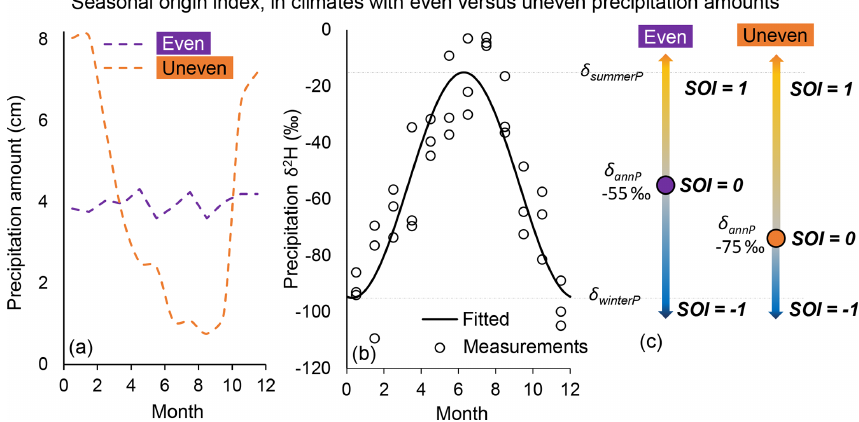
Figure 1. Calculation of the seasonal origin index (SOI). As a hypothetical example, consider one site that receives equal precipitation amounts throughout the year and another site that receives more precipitation in winter (a) , but both have the same seasonal isotopic cycle (b) . In this example, the volume-weighted average precipitation is − 75‰ δ 2 H in the uneven-precipitation site and − 55‰ δ 2 H in the even- precipitation site (c) ; these values mark SOI = 0. Thus, if water with − 60‰ δ 2 H was observed in xylem in the uneven-precipitation site, SOI would be positive, indicating that each millimeter of rain that fell during the summer made a larger contribution to xylem water than each millimeter of rain that fell during the winter (even though, owing to the greater precipitation in winter, winter precipitation made up more than 50% of the xylem water). Panel (b) also shows how the seasonal precipitation isotope cycle is defined by a fitted sinusoid, such that the amplitude captures typical summer and winter peaks and not the absolute bounds of possible values (i.e., SOI of soil or xylem water can be higher than 1.0 or lower than − 1 .